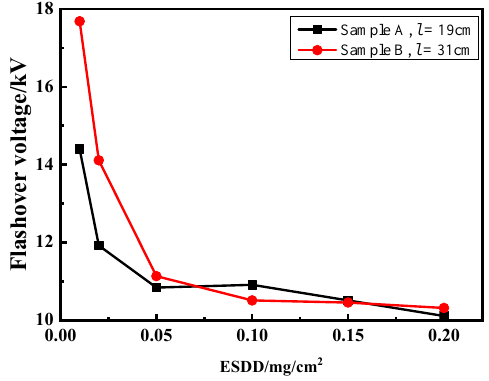
Figure 6. Flashover voltage results of samples with different leakage lengths.